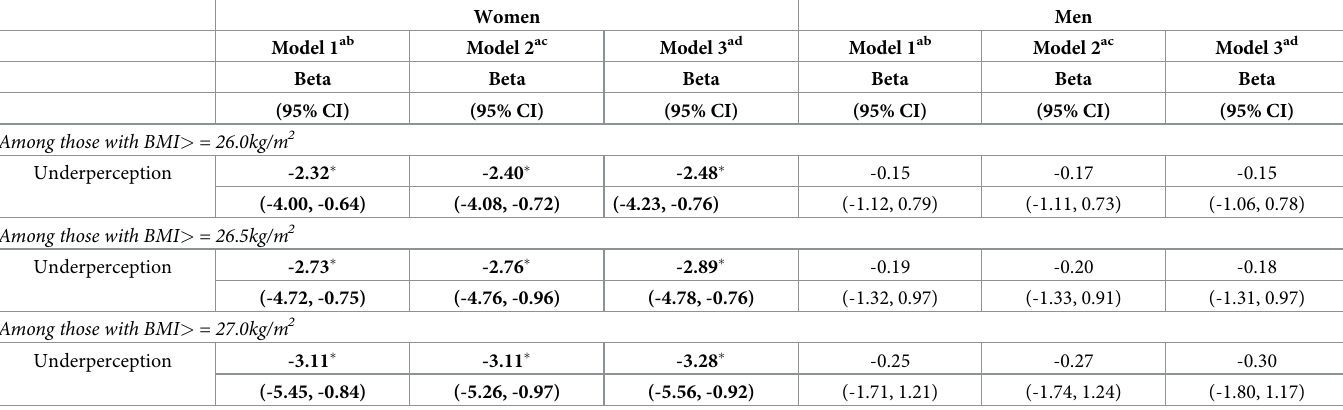
Table 6. Sensitivity analysis of multilevel linear models for depressive symptoms (PHQ-9K) among Korean women with varying cut-offs for